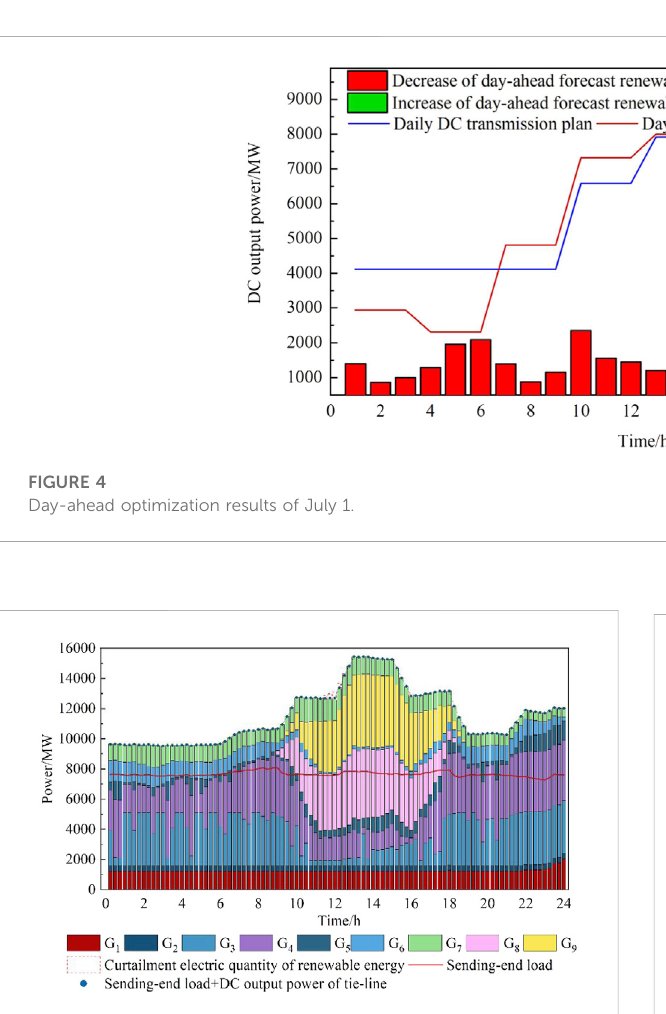
FIGURE 5 Intra-day optimization results of January 22.